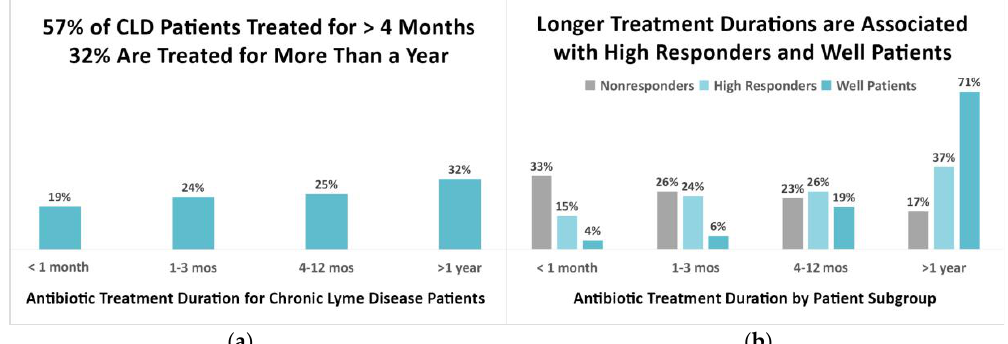
Figure 5. ( a ) Most CLD patients (57%) are treated for more than four months; 32% are treated for more than a year. ( b ) Most high responders (63%) and well patients (90%) report being treated for